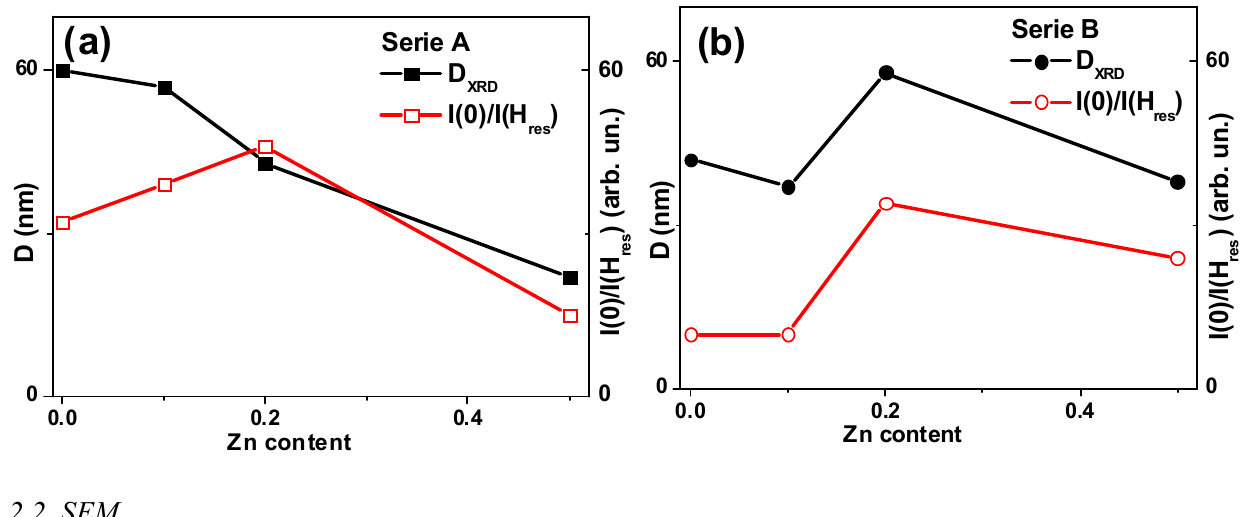
Figure 2. Crystallite size D obtained from the XRD analysis and evolution of zero field XRD absorption as a function of Zn concentration for series A ( a ) and B ( b ) samples.